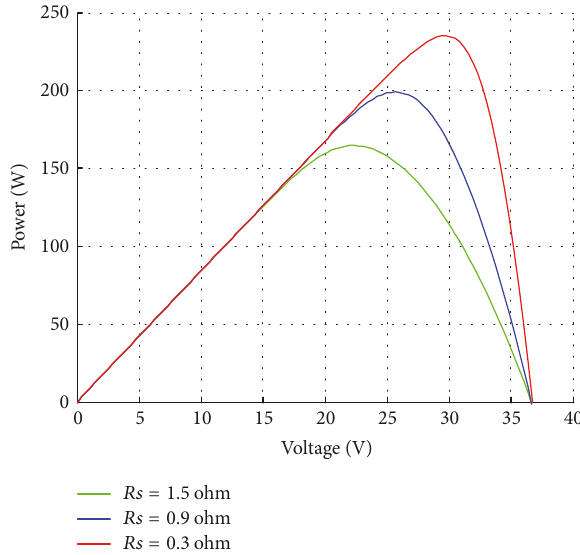
Figure 12: 𝑃 - 𝑉 curves for different 𝑅 s .